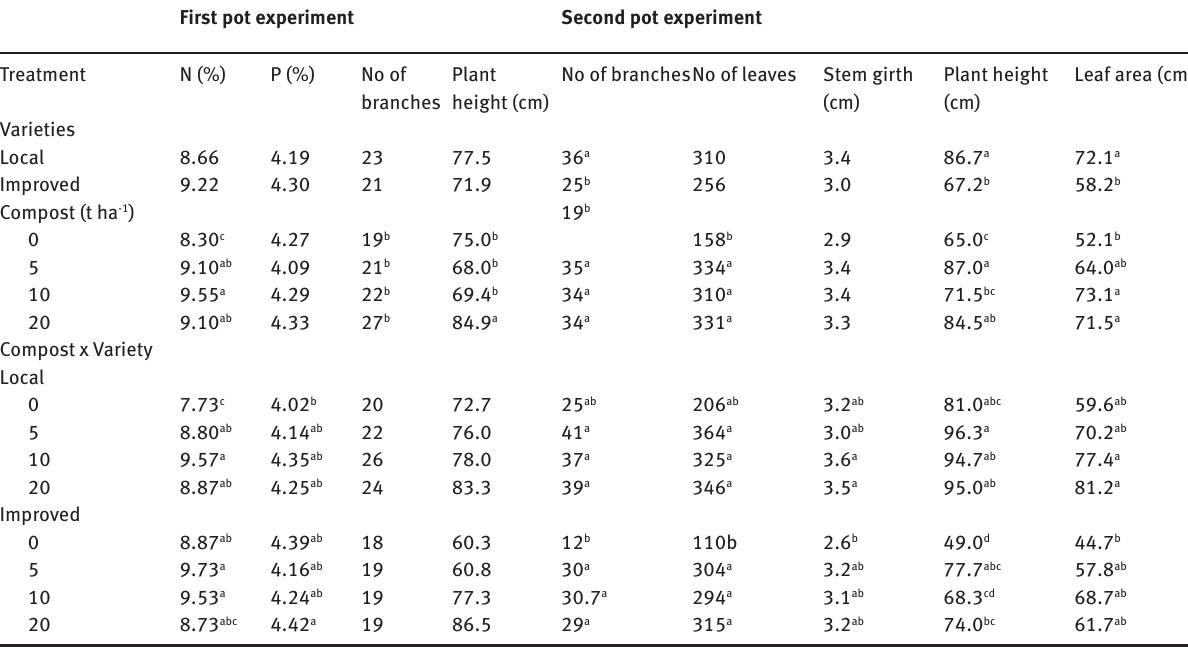
Table 5: Nutrient concentrations and growth characteristics of 2 tomato varieties in pot experiments amended with 4 rates of